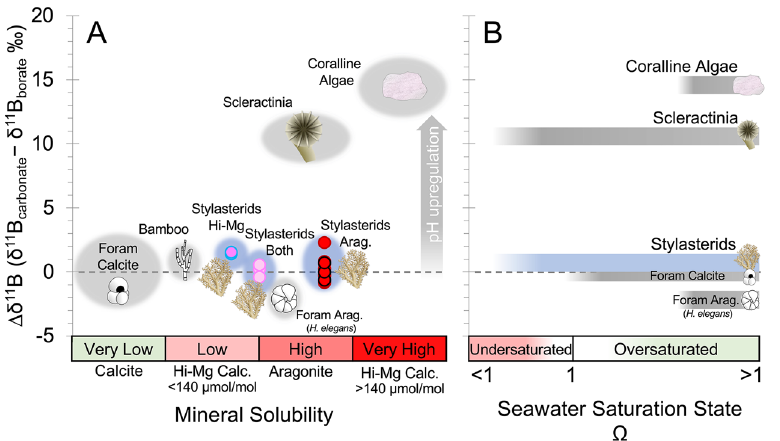
Figure 2. Skeletal carbonate δ 11 B offset from δ 11 B of borate in seawater (∆δ 11 B)—a measure of calcifying fluid pH upregulation—compared to ( A ) mineralogy and ( B ) carbonate ion saturation of seawater (Ω) habitat. Stylasterid coral ∆δ 11 B are compared to published δ 11 B values for aragonitic scleractinia 16,30,31 , high-Mg calcitic bamboo corals 32 , calcitic and aragonitic foraminifera 35 , and crustose coralline algae 18,21,22 . Mineral solubility from 7